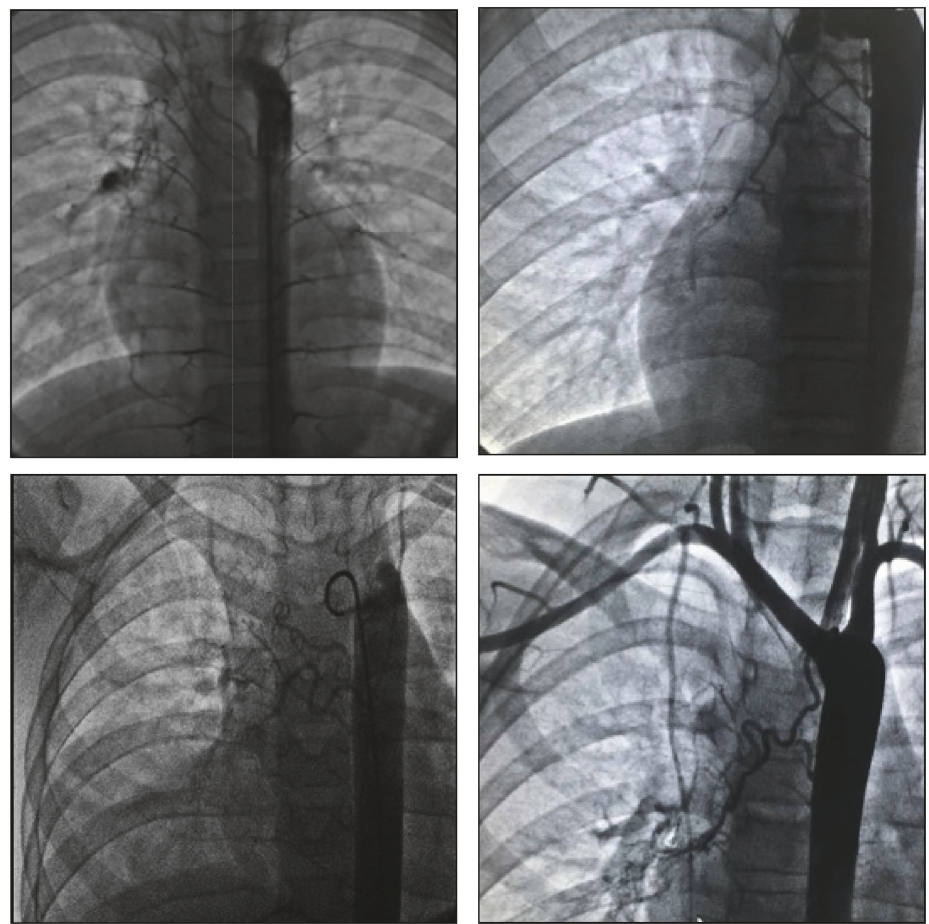
Figure 2: DSA display for anomalous BAs. 2A: the two visible abnormal BAs originated from the thoracic and the abdominal aortas, jointly leading to vascular rupture; 2B: a tortuous BA was clearly presented from the right side of the thoracic trunk, which paralleled the right inferior lobar bronchus; 2C: the right BAs were displayed, and a normal BA paralleled the superior lobar bronchus, while two abnormal BAs with abnormal routes paralleled the inferior lobar bronchus; 2D: two tiny and tortuous arteries apparently repealed, respectively, and originated from the aortic arch and thoracic aorta, forming connecting branches and bleeding in the middle lobe of the right